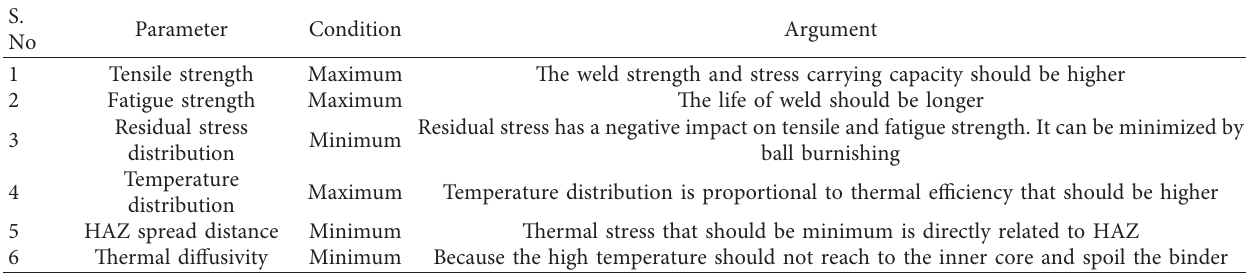
Table 10: Parameter characterization.